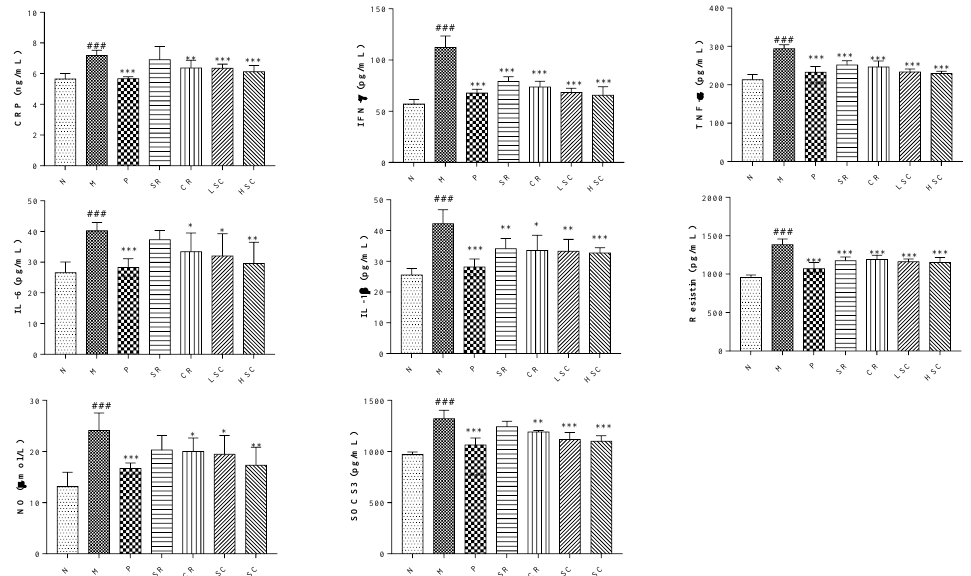
Figure 3. Serum contents of C-reaction protein (CRP), interferon gamma (IFN- γ ), tumor necrosis factor- α (TNF- α ), interleukin-6 (IL-6), interleukin-1 β (IL-1 β ), resistin, nitric oxide (NO) and suppressor of cytokine signaling 3 (SOCS3) in the normal group (N), model group (M), and groups gavaged with metformin (P), scutellaria Radix (SR), coptidis Rhizome (CR), low dose of combined extracts group (LSC) and high dose of combined extracts (HSC). The values were shown as mean ± SD. # p < 0.05, ## p < 0.01, ### p < 0.001 vs. normal group; * p < 0.05, ** p < 0.01, *** p < 0.001 vs. model group. Data were analyzed by One-way-ANOVA.